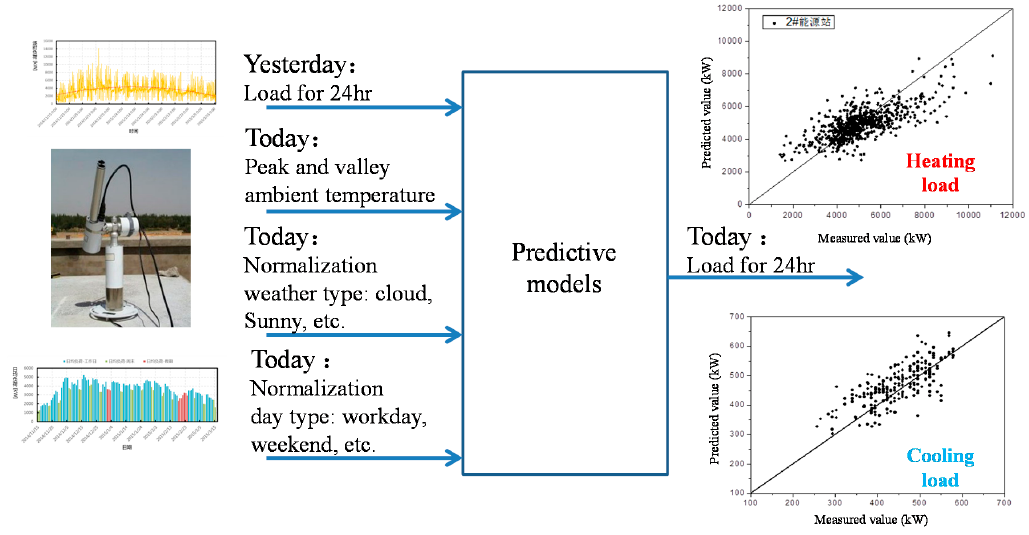
Figure 4. Model for the load forecasting.